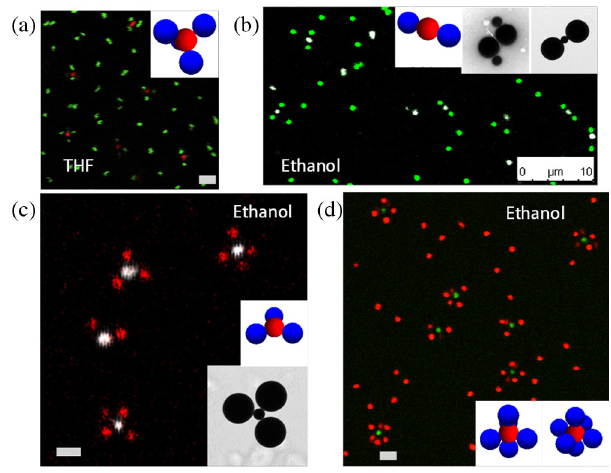
FIG. 2. Clusters composed of positively charged titania and negatively charged silica or of positively and negatively charged silica-silica colloids: (a) 600 nm positively charged silica (red) and 1 . 1 μ m negatively charged silica (green) particles in THF, which still retain the repulsions between the clusters (forming mainly AB 3 and AB 4 clusters), (b) 450 nm positively charged titania (white) particles permanently linked to the 1 . 7 μ m negatively charged silica (green) particles in ethanol, which form mainly AB 2 clusters, (c) 450 nm positively charged titania (white) particles permanently linked to the 1 . 3 μ m negatively charged silica (red) particles in ethanol, (d) 1 . 1 μ m positively charged silica (green) permanently linked to 1 . 3 μ m negatively charged silica (red) particles in ethanol, which form mainly AB AB 5 and 6 clusters. Insets show transmission electron micro- graphs and schematic drawings of permanently linked